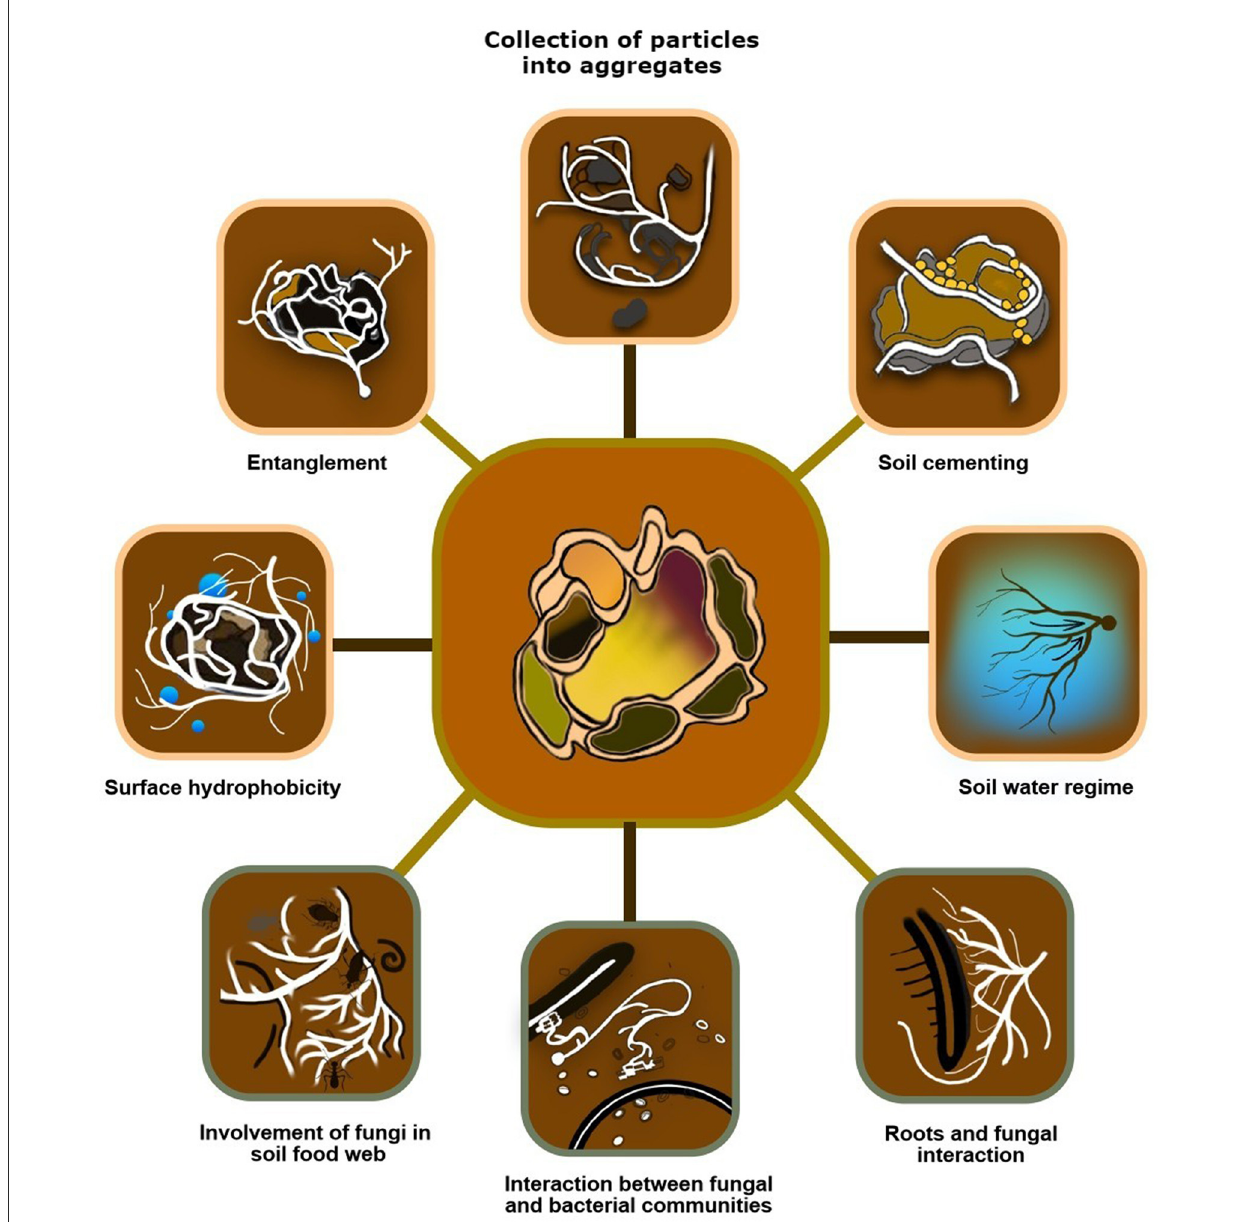
FIGURE3 Roles of AMF in soil